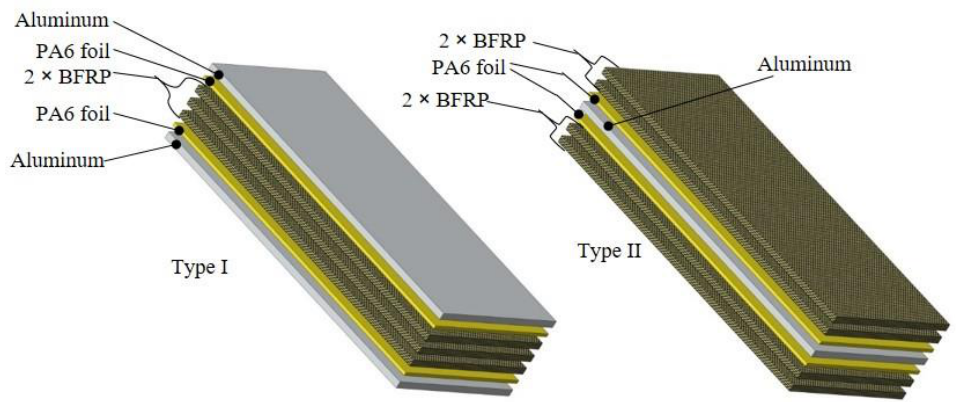
Figure 1. Type I and Type II basalt fiber reinforced polymer laminates (BFRPL). BFRP: basalt fiber reinforced